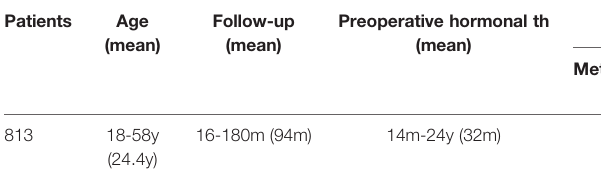
TABLE 1 | Patients ’ demographic characteristics and type of